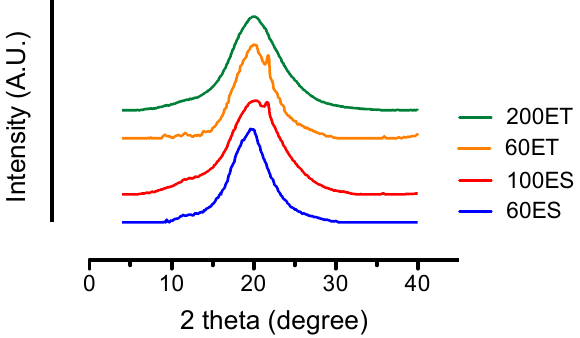
Figure 5. XRD patterns of the various PU films, showing a broad peak at 2 θ = 20 ◦ related to semicrystalline structure of the hard / soft segments in PUs. The small peaks at the shoulders of the 100ES and 60ET groups are attributed to the partial crystallization of the soft